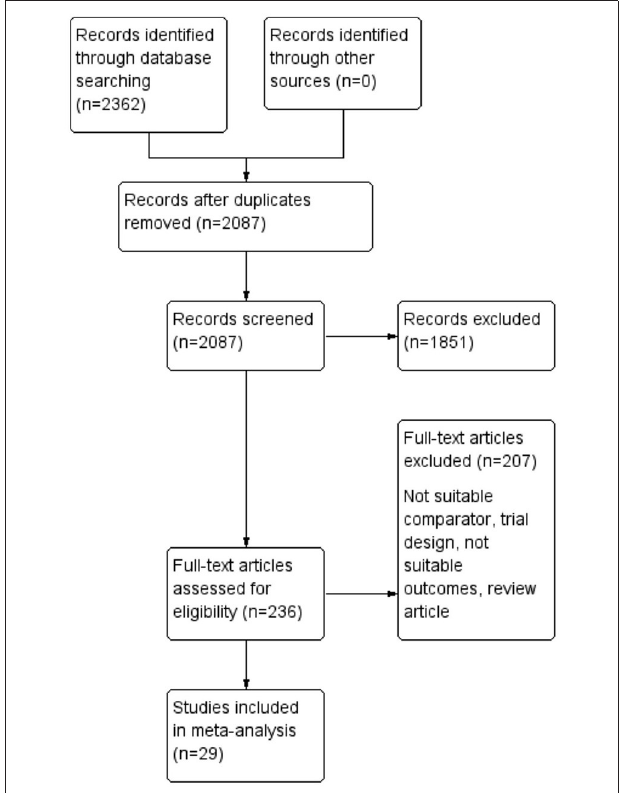
FIGURE 1 | A flow chart for the identification and inclusion of studies in the meta-analysis according to Preferred Reporting Items for Systematic and Meta-Analyses (PRISMA).